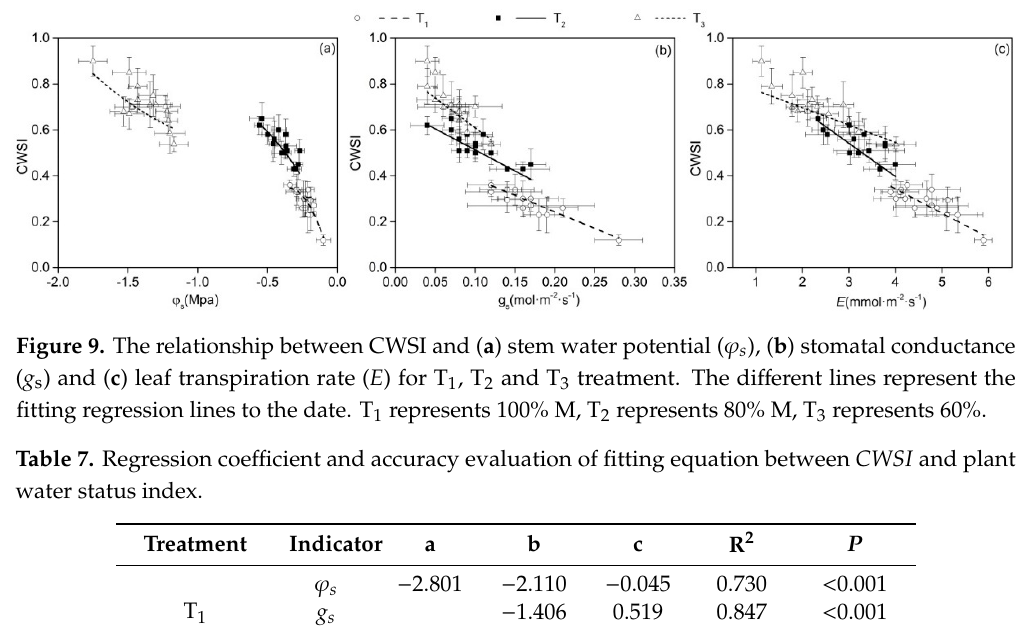
Figure 8. The relationship between the CWSI and the soil moisture of different layers under different treatments. ( a ) represents the relationship between soil moisture content of 0–40 cm and CWSI; ( b ) represents the relationship between soil moisture content of 0-80 cm and CWSI. T 1 represents 100% M, T 2 represents 80% M, T 3 represents 60%. The relationship between plant water status indictors ( s ϕ , g s and E ) and CWSI were close (Figure 9), and the R 2 were high (Table 7). Moreover, the relationships between CWSI and s ϕ , g s and E were significant at the level of P < 0.01, which indicated that CWSI is a suitable indicator for the diagnosis of plant water status. The relationship between g s and CWSI was the closest, the R 2 was between 0.708 and 0.847, whereas the relationship between s ϕ E and CWSI was 0.565–0.730 and 0.569–0.711, respectively (Table 7). When the CWSI is compared to T c -T a as a proxy of the water status (by comparing the R 2 and P values of the relationship of both indices to s ϕ , g s , and E , Tables 5 and 7), it can be observed that the CWSI more accurately represents the crop water status. Compared to T c - T a , the performance of the CWSI is improved by considering the evaporative demand and the species- specific response of the relationship to VPD. These results are similar to the theoretical foundation of CWSI, demonstrating that the change of leaf temperature is mainly determined by the change of g s under water stress [59]. Under water stress, the stem and leaf water potential reached the lowest through stomatal regulation, which also explained that the correlation between CWSI and leaf, stem water potential and transpiration rate was not high. Berni et al. [60] reported that for olive trees, there is a linear relationship between CWSI and g s , the same results were also confirmed in nectarines [61]. The relationship between E and CWSI was weaker than that with g s (Table. 7), although the transpiration rate of leaves depended largely on g s , the reason may be that transpiration rate is not only affected by stomatal conductance but also on the conductivity of the boundary layer [62].